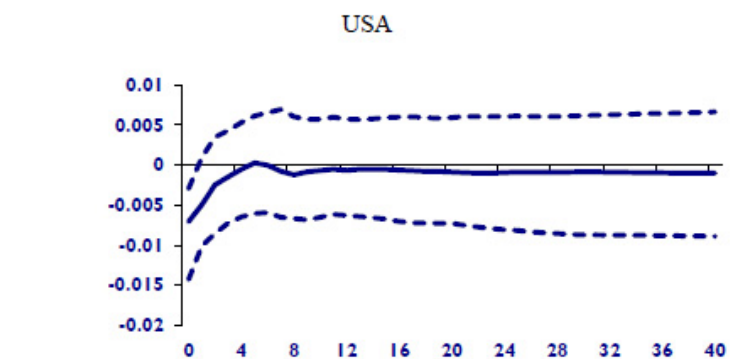
Figure 7. GARCH-based oil price uncertainty shocks and real stock prices ( country-specific ). Note: The figure depicts the country-specific impulse response functions of real stock prices to a one standard deviation increase in oil price uncertainty. The median impulse response is presented in solid lines, while the 16–84% lower and upper bootstrapped error bands are shown in dotted lines. The impact is measured in percentage points (by multiplying the estimates in the figure by 100) over the quarterly horizon.